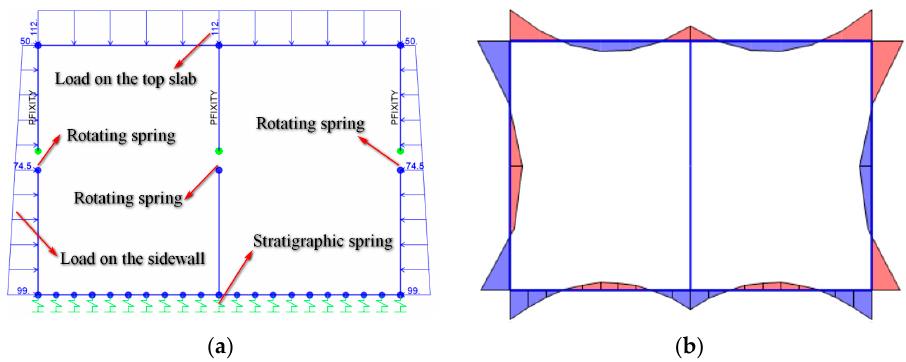
Figure 4. Finite element analysis model and results schematic: ( a ) analysis model and ( b ) bending moment diagrams.